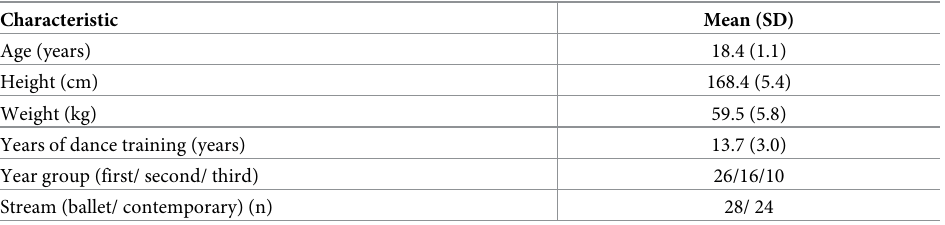
Table 1. Participant characteristics.